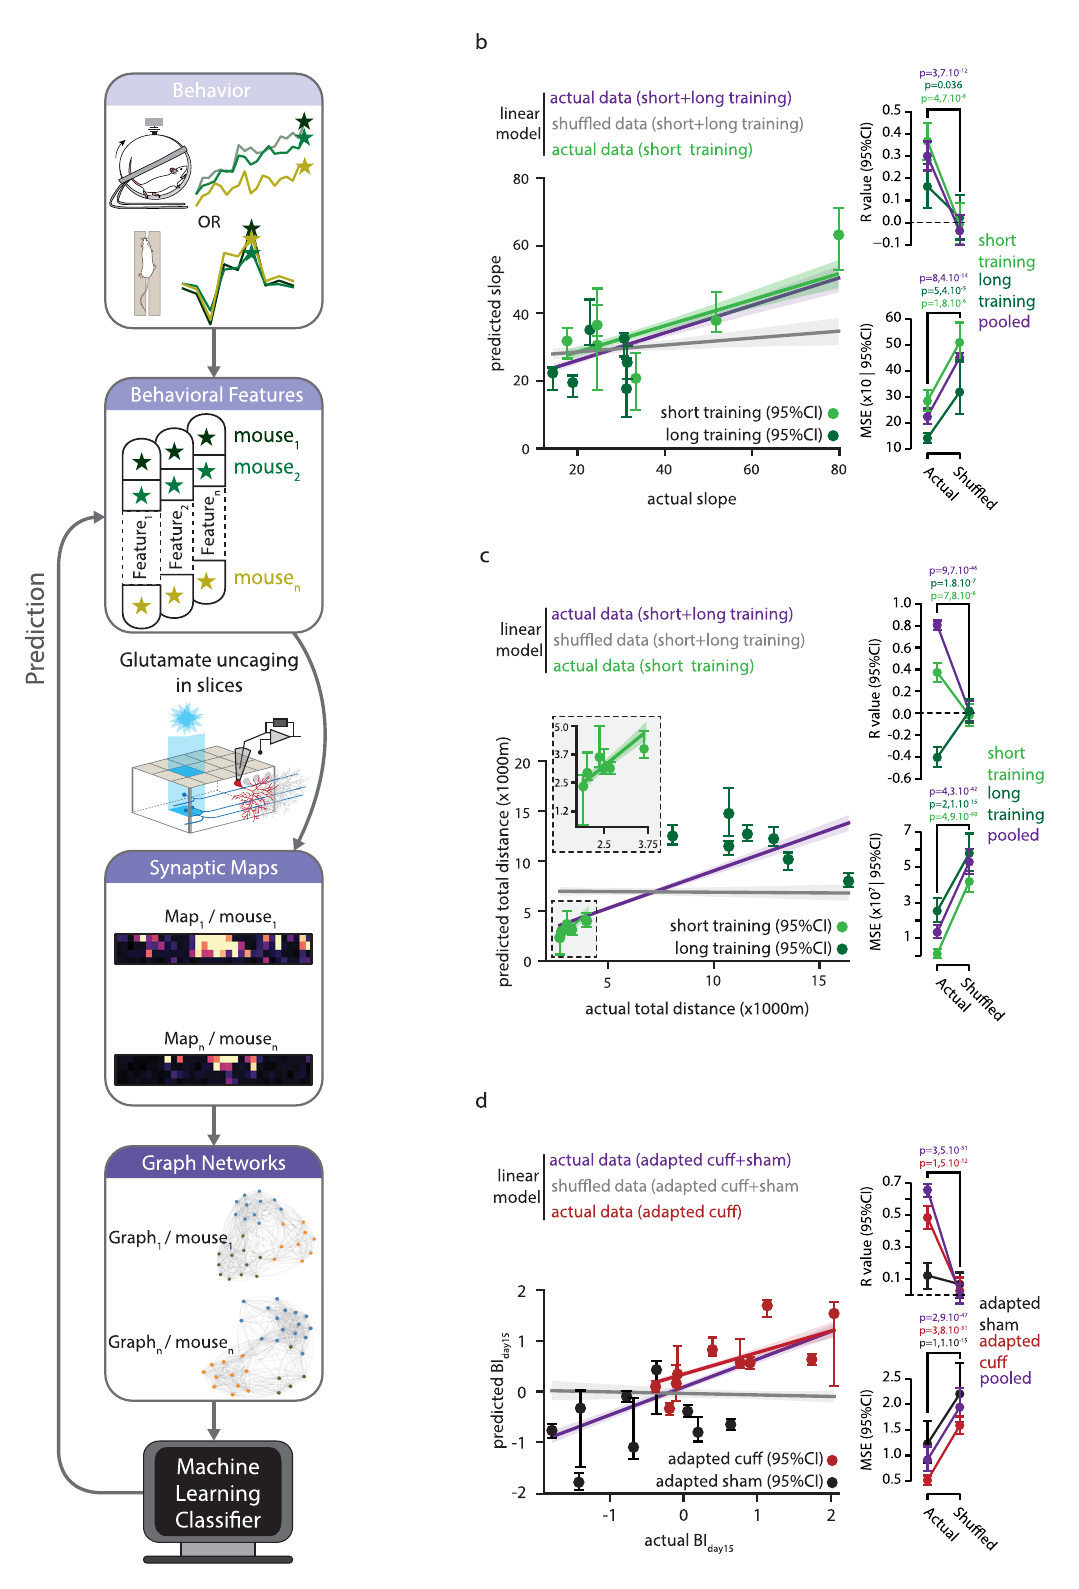
considered (Fig. 6b). Even if behavior predictions are performed in terms of the multi-dimensional input vector of whole graph metrics, the model coef fi cients for the assortativity feature had a larger absolute value than all other features and a negative sign for the prediction of both slope and total distance of wheel training (Supplementary Fig. 10a, b). It means that maps with